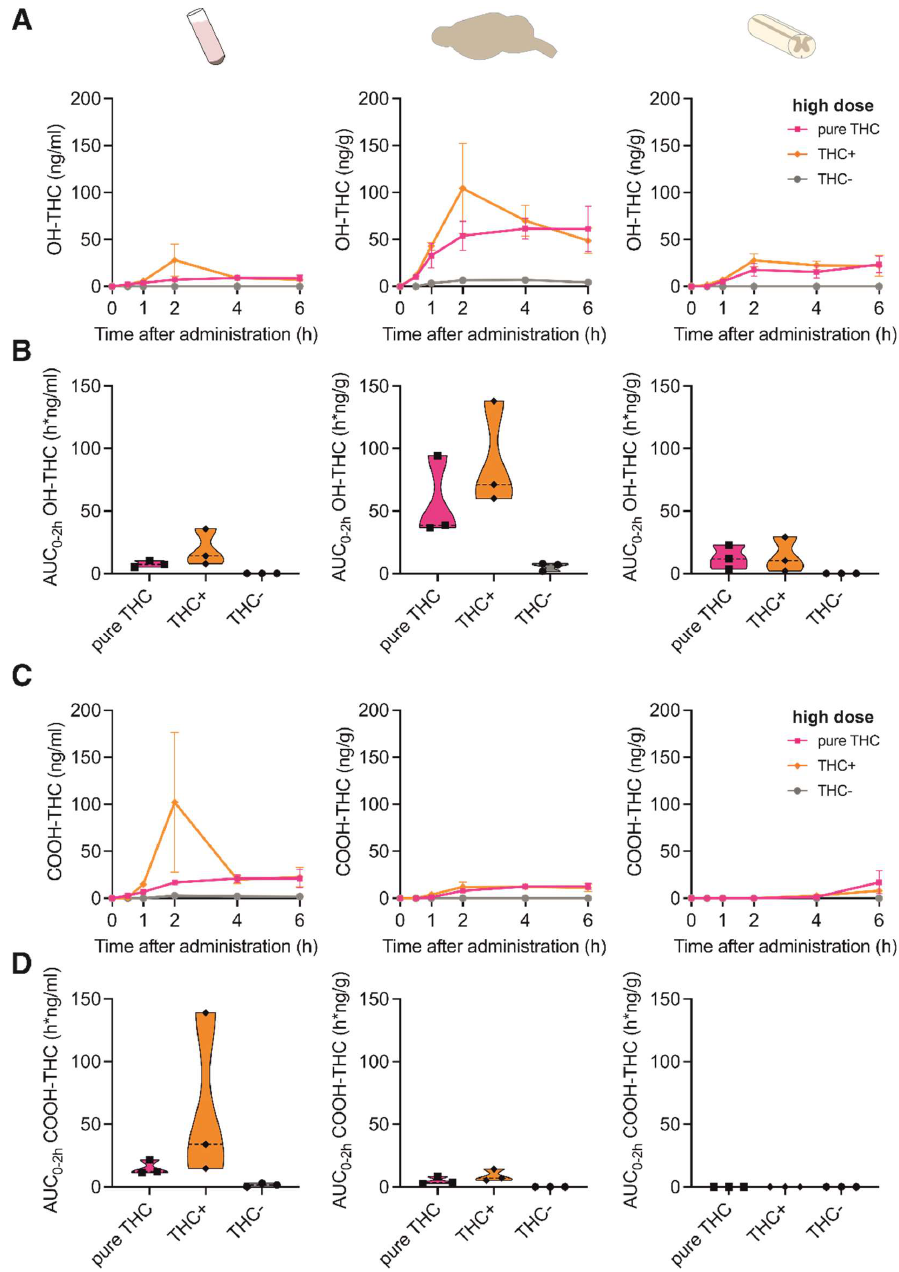
Figure 2. Pharmacokinetic profile of THC metabolites following oral administration of cannabis extracts and pure THC compound. ( A ) Concentration-time profiles of OH-THC in plasma, brain and spinal cord at 0, 1, 2, 4 and 6 h after oral administration of 20 mg/kg pure THC compound, 40 mg/kg THC+ extract and 1560 mg/kg THC- extract. Data are represented as mean ± SEM, n = 3 per timepoint. ( B ) AUC 0–2h of OH-THC concentrations calculated for data shown in ( A ). ( C ) Concentration-time profiles of COOH-THC in plasma, brain and spinal cord at 0, 1, 2, 4 and 6 h after oral administration of 20 mg/kg pure THC compound, 40 mg/kg THC+ extract and 1560 mg/kg THC- extract. Data are represented as mean ± SEM, n = 3 per timepoint. ( D ) AUC 0–2h of COOH-THC concentrations calculated for data shown in ( C